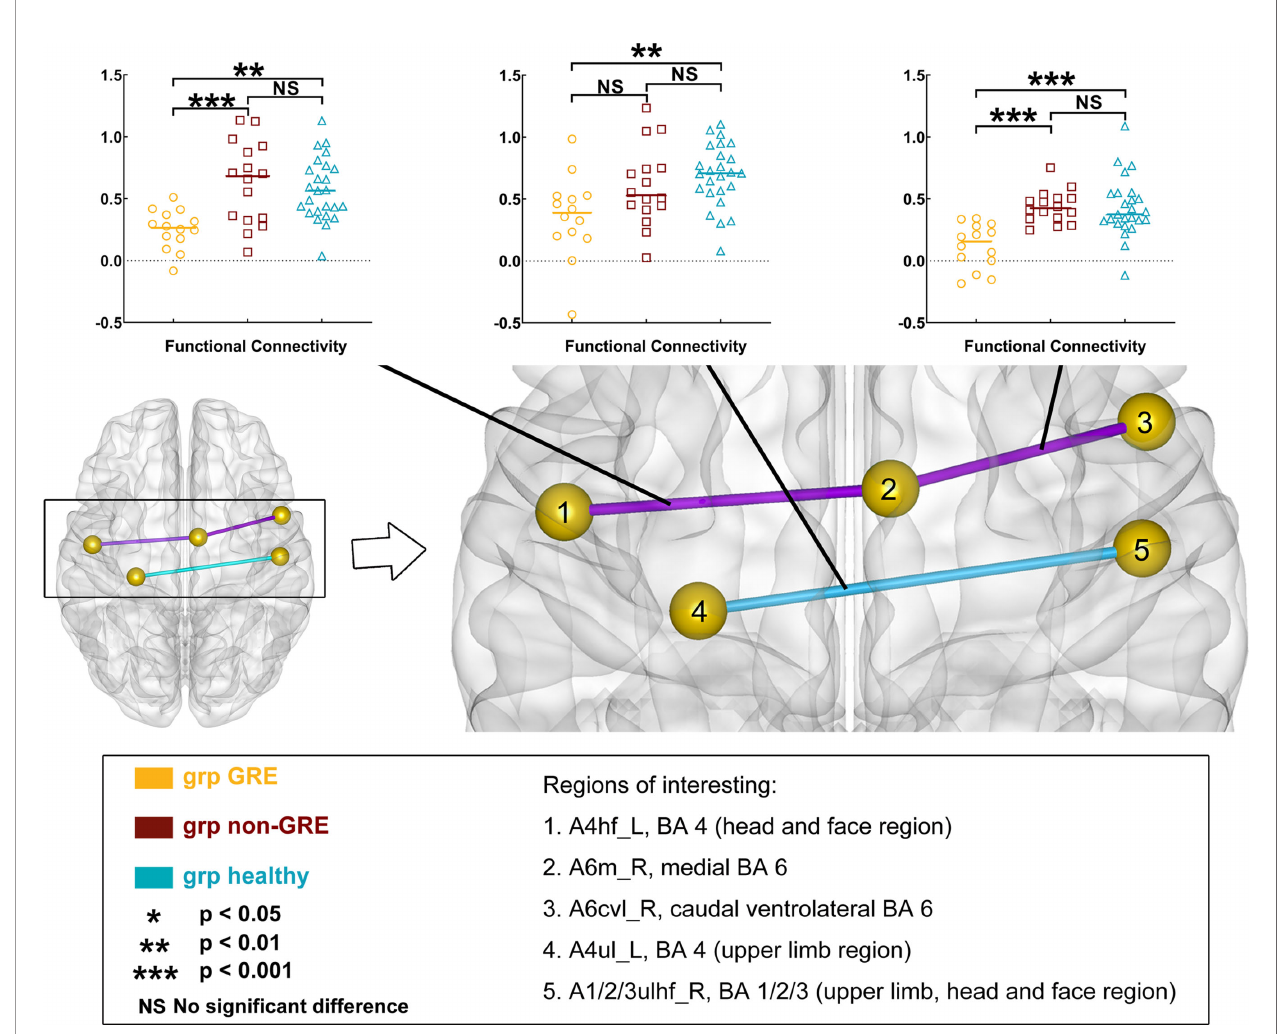
FIGURE 3 | Results of alterations in functional connectivity (FC) when gliomas grew in the right prefrontal lobe. The grp GRE (n = 14), group of patients with glioma- related epilepsy. The grp non-GRE (n = 16), group of patients without glioma-related epilepsy. The grp healthy (n = 25), group of healthy